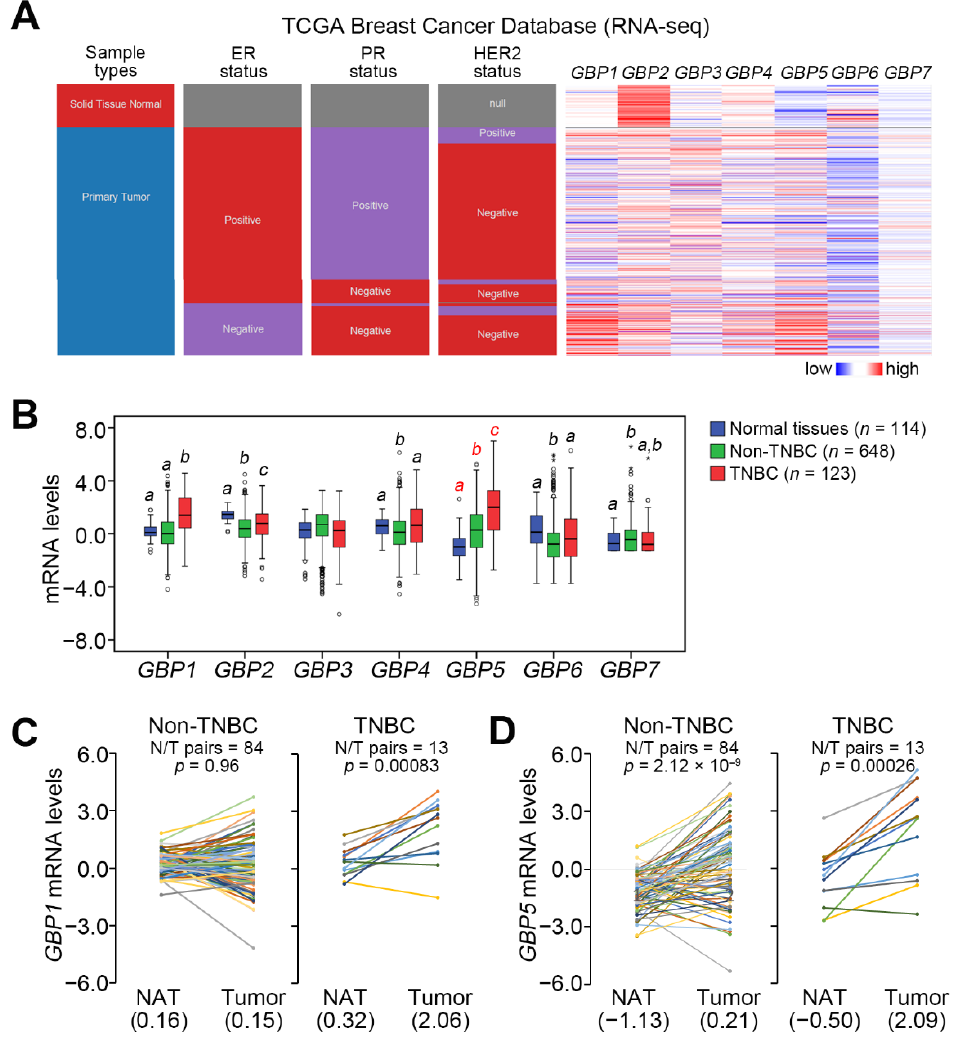
Figure 1. GBP5 (guanylate binding protein 5) is predominantly upregulated in TNBC (triple-negative breast cancers) compared to normal mammary and non-TNBC tissues. ( A ) Heatmap for the transcriptional profiling of genes encoding GBP1, GBP2, GBP3, GBP4, GBP5, GBP6 and GBP7 using the TCGA breast cancer database. ( B ) Boxplot of the mRNA levels of GBP1, GBP2, GBP3, GBP4, GBP5, GBP6 and GBP7 in normal tissues and primary tumor-derived non-TNBC and TNBC patients from the TCGA breast cancer database. Statistical significance was estimated by one-way ANOVA using Tukey’s post hoc test. Different letters indicate statistical significance at p < 0.01. ( C , D ) The mRNA levels of GBP1 ( C ) and GBP5 ( D ) in the paired normal adjacent tissues (NATs) and primary tumors, as shown in each colored lines, derived from TCGA non-TNBC and TNBC patients. The inserted values represent the median of GBP1 and GBP5 mRNA levels in NATs and primary tumors. The N/T pairs indicate NAT/primary tumor pairs. The statistical significance was evaluated by paired t